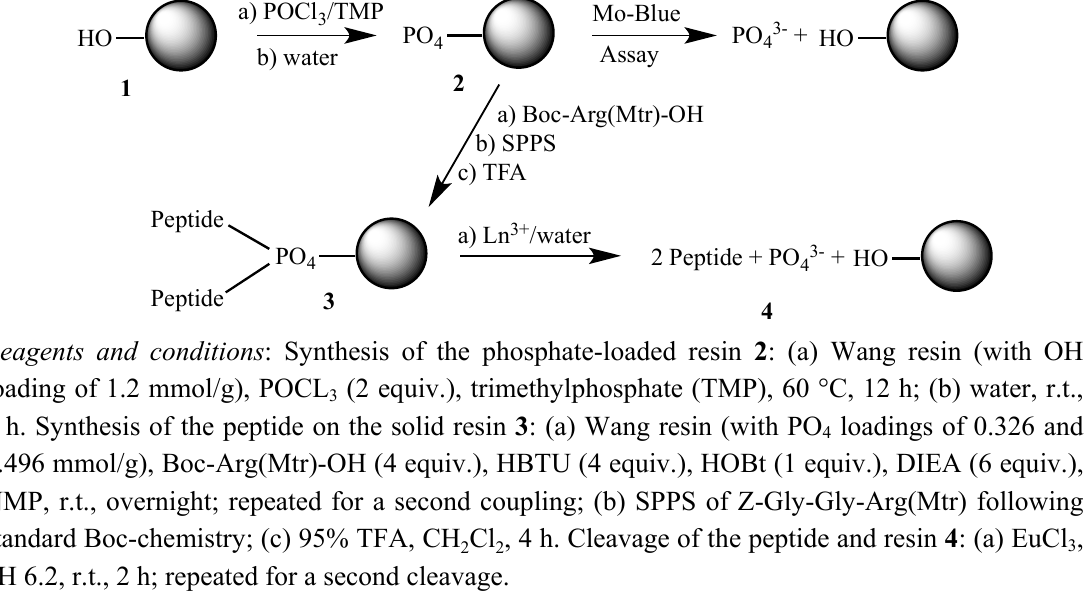
Figure 1. Calibration curve for phosphate quantification using KH standard. The peak absorbance was observed at 825 nm, which showed a 5 nm difference.